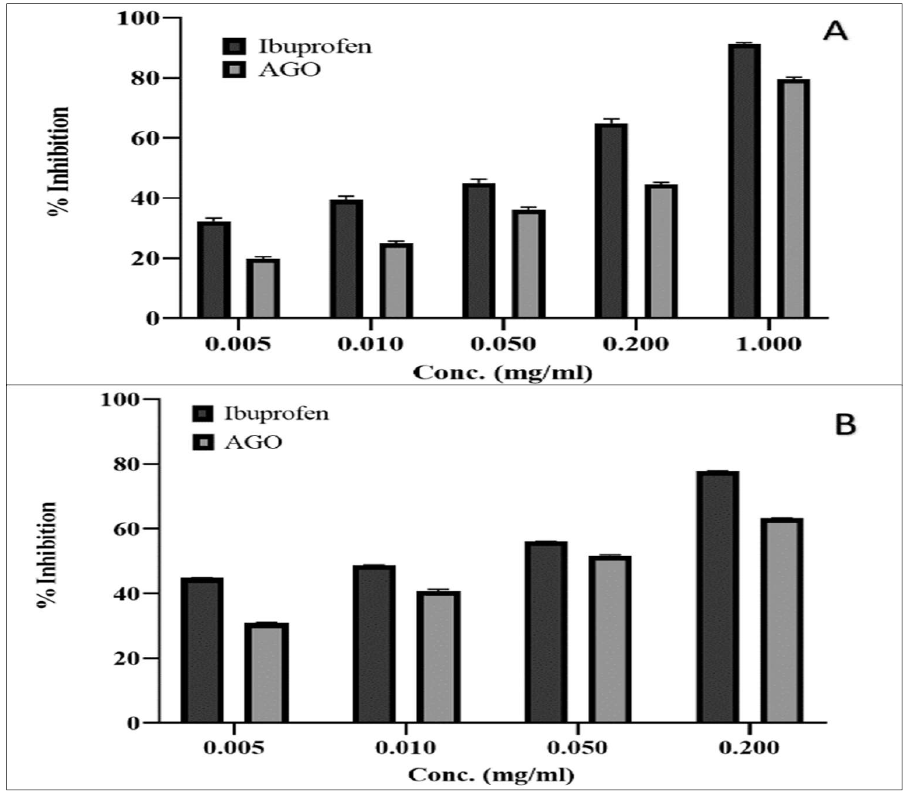
Figure 3. Anti-inflammatory activity of the Apium graveolens oil (AGO), ( A ): Egg albumin; ( B ): Trypsin inhibitory method.